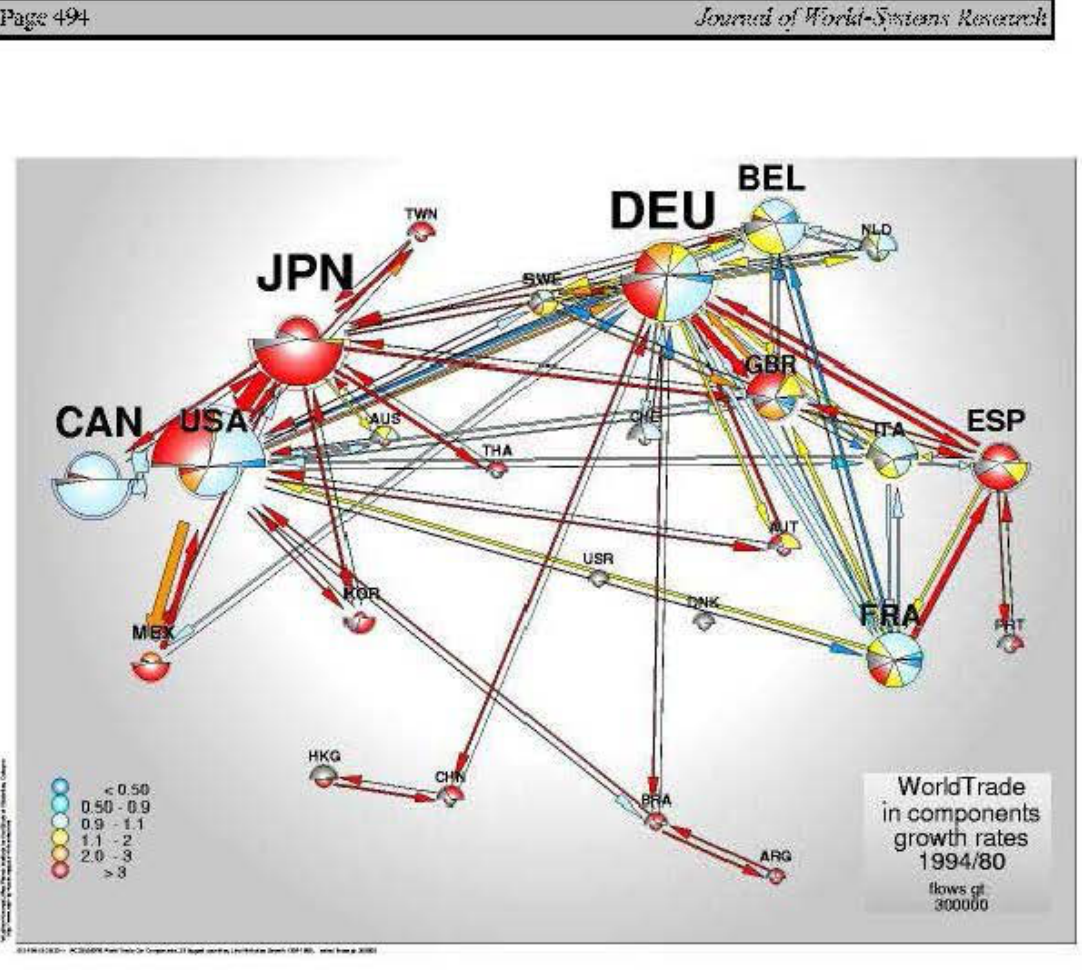
Figure 5: C'.tro'INth Rares for Trade in Parts and Component,